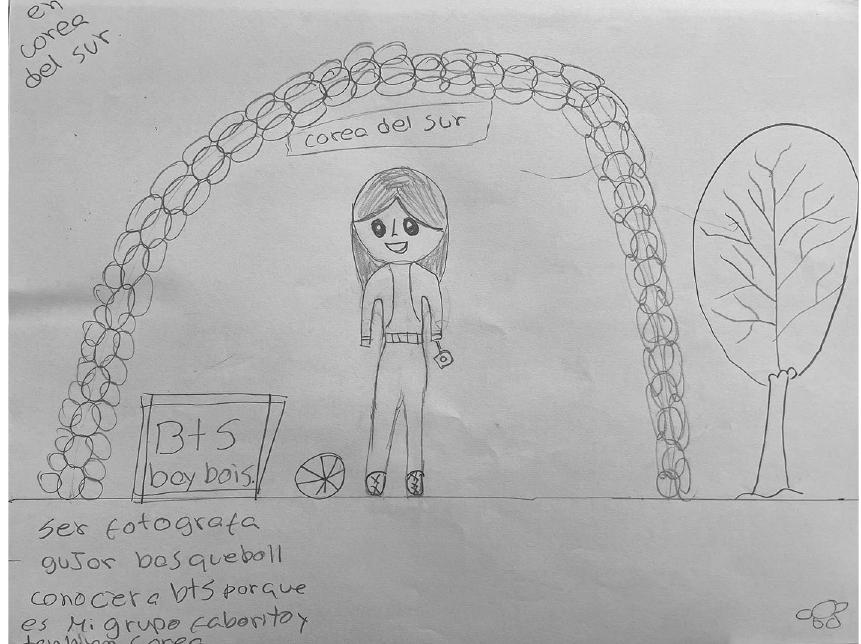
Fig. 2 SPF Drawing of a secondary school student in the